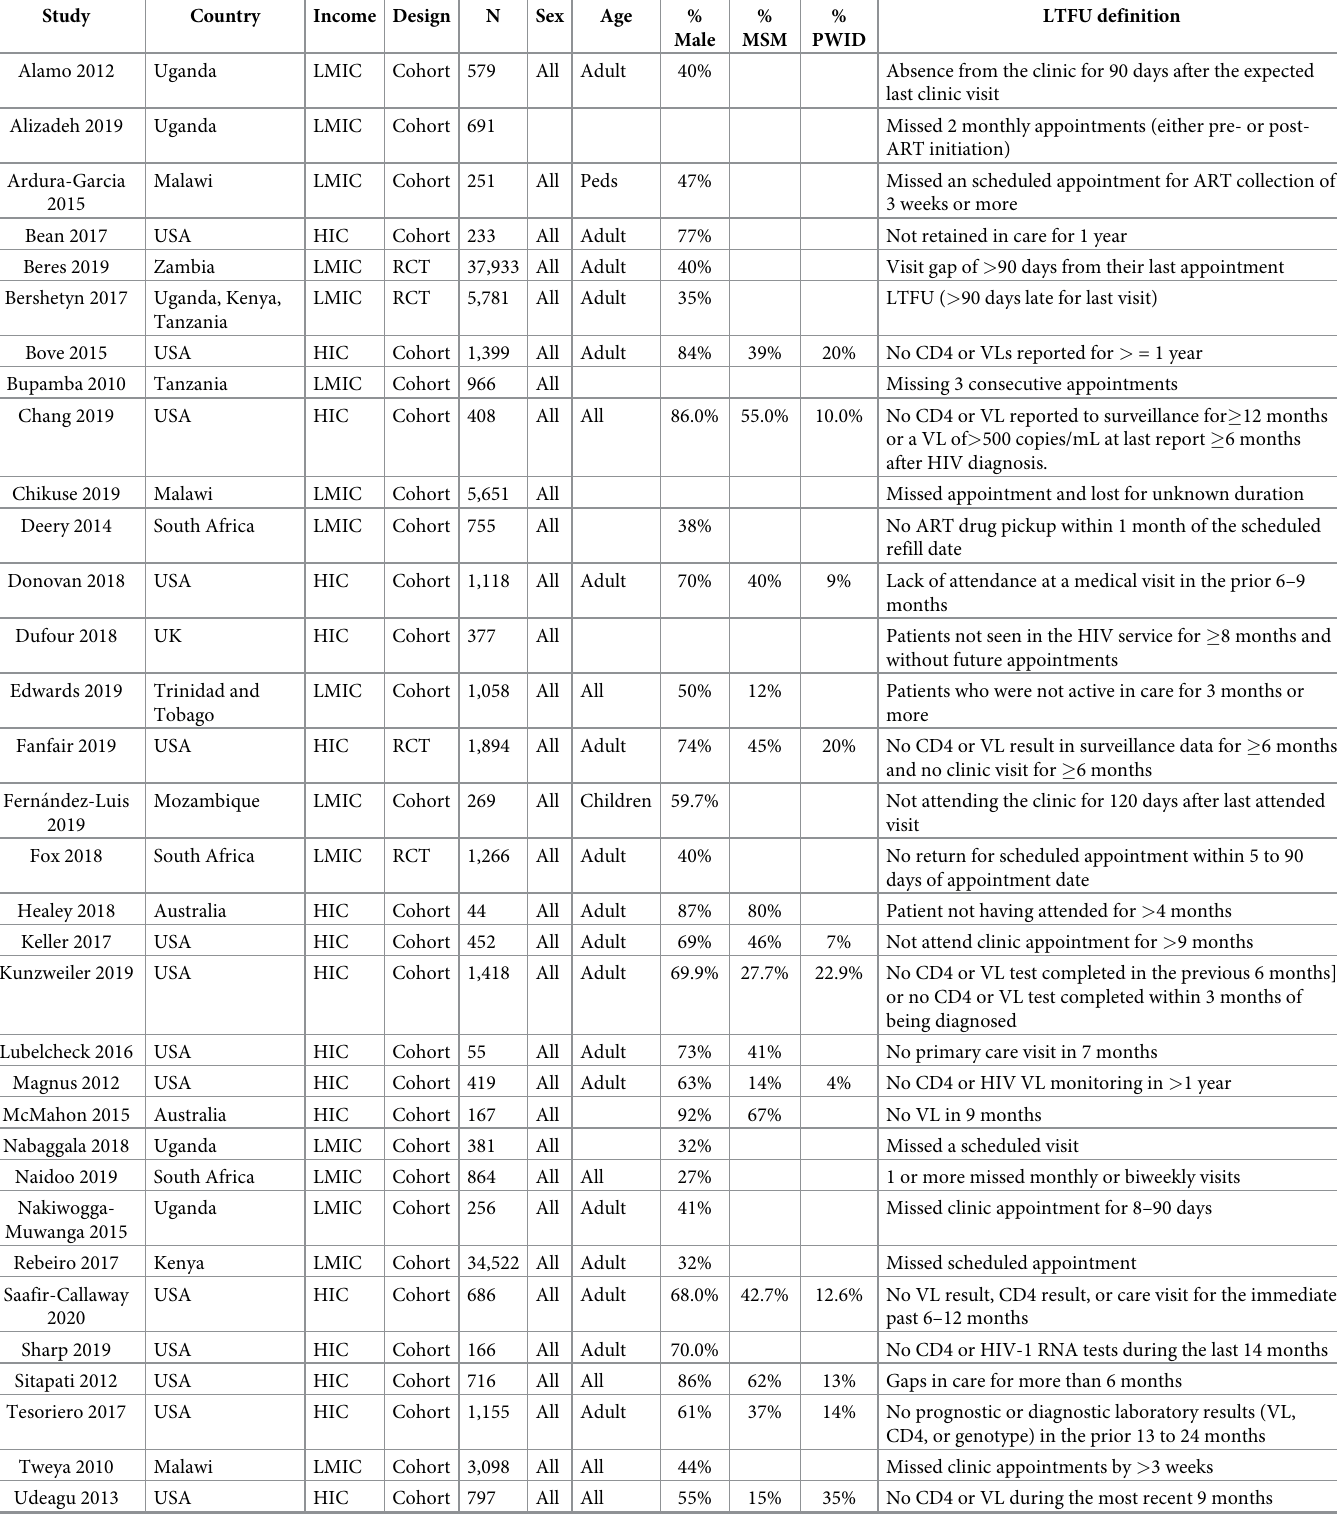
Table 1. Characteristics of included